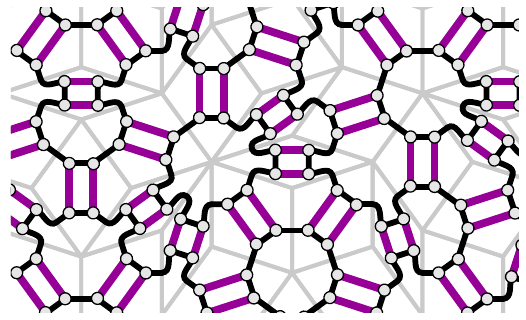
FIG. 16. The rhombic Penrose tiles (light gray) decorated with edges (black), vertices, and dimers (purple) such that each tile of the same type is identical, and the resulting bipartite graph admits a perfect